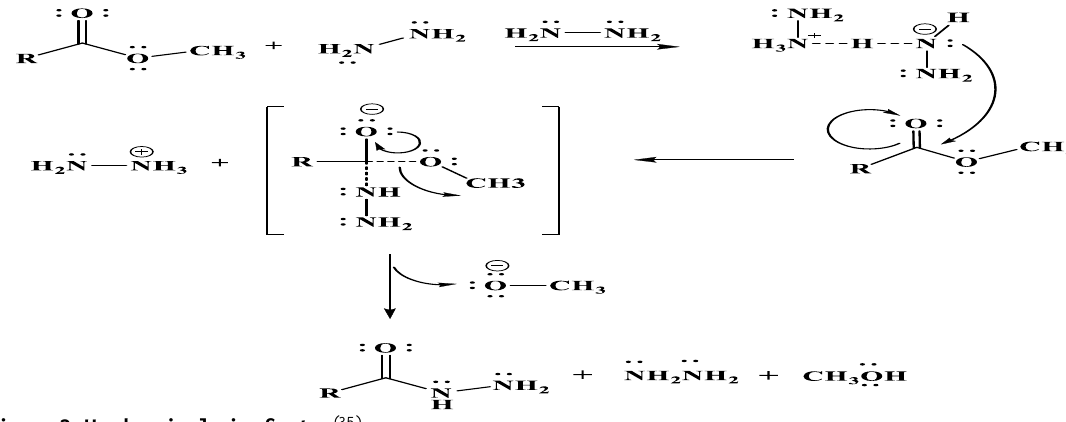
Figure 3. Hydrazinolysis of ester (35) .